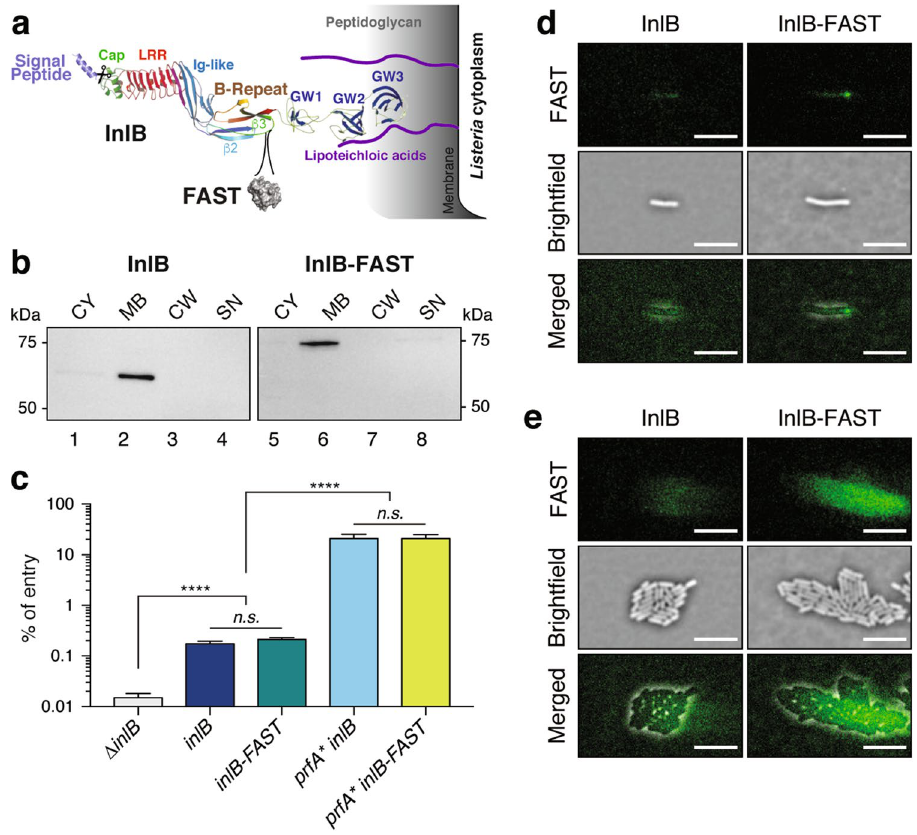
Figure 6. Re-localisation of InlB-FAST from stationary to exponential phase. ( a ) Diagram of the InlB-FAST construct anchored to the surface of L. monocytogenes . The insertion position of FAST, between the leaflets β2 and β3 of the "B-repeat" domain is indicated. ( b ) Western blot against InlB for L. monocytogenes producing InlB or InlB-FAST. CY = cytoplasmic fraction; MB = membrane fraction; CW = wall fraction; SN = supernatant fraction, the image has been cropped from a larger blot as depicted in Supplementary Information file S8. c. The percentage of entry of L. monocytogenes in HeLa cells was assessed by gentamicin protection assay. It was expressed as the ratio of recovered colony-forming units counted from cell lysates at 2 h post-infection, to the initial number of bacteria in the inoculum. Plotted data represents average and standard deviation from three independent wells in a representative experiment. Adjusted p values were obtained by one-way ANOVA on log 10 -transformed percentages of entry for each well (N = 3). The experiment was reproduced thrice independently. ****, p < 10 –7 . ( d , e ) L. monocytogenes prfA * that produced either InlB or InlB-FAST were grown in BHI with 20 µM HBR-3,5DM and imaged by TIRF microscopy. The contrast was the same on all images. Cells were resuming from stationnary phase in ( d ) and were in exponential phase in e . The microcolonies shown in e have developed from the cells shown in ( d ). Scale bar, 5